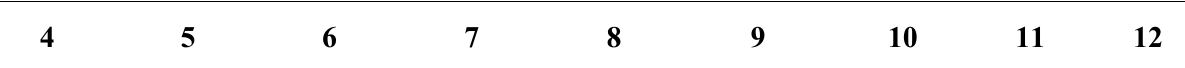
Table 2. Correlations among the measured parameters in the